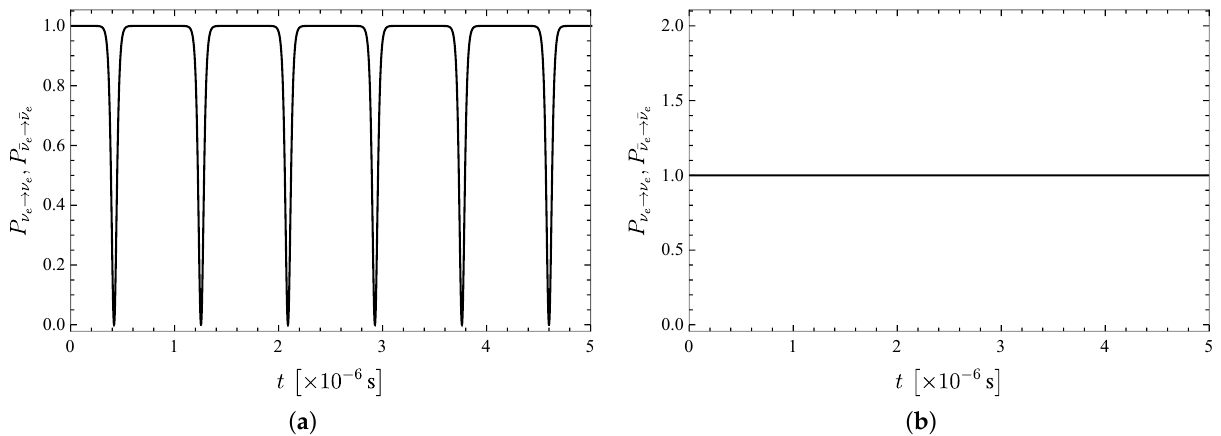
Figure 6. Survival provability for electron neutrinos and antineutrinos for the accretion disk with ˙ M = 0.1 M (cid:12) s − 1 at r = 10 r s . The survival probabilities for neutrinos and antineutrinos in both plots coincide. ( a ) Inverted hierarchy and ( b ) normal